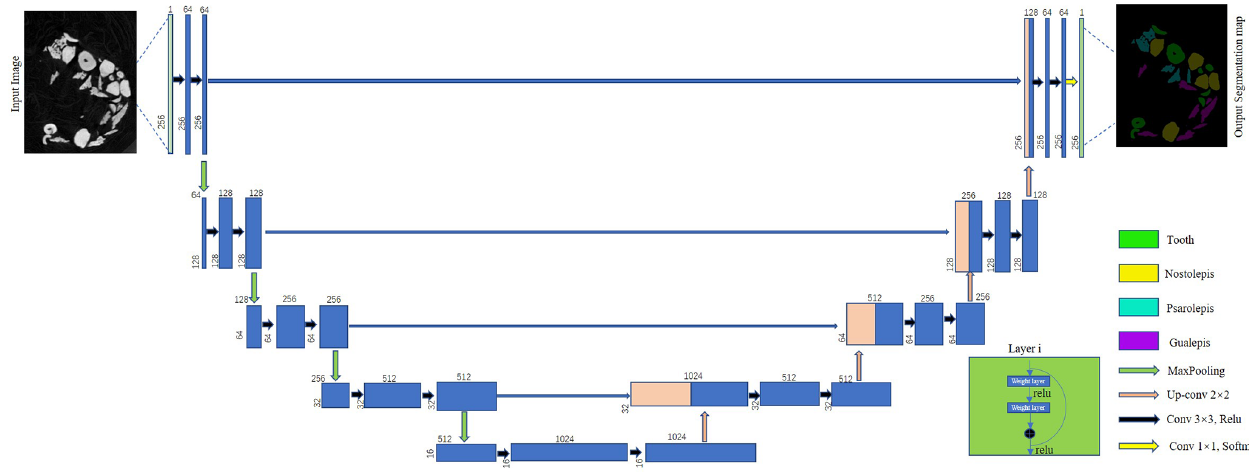
Figure 5. U-Net + ResNet34